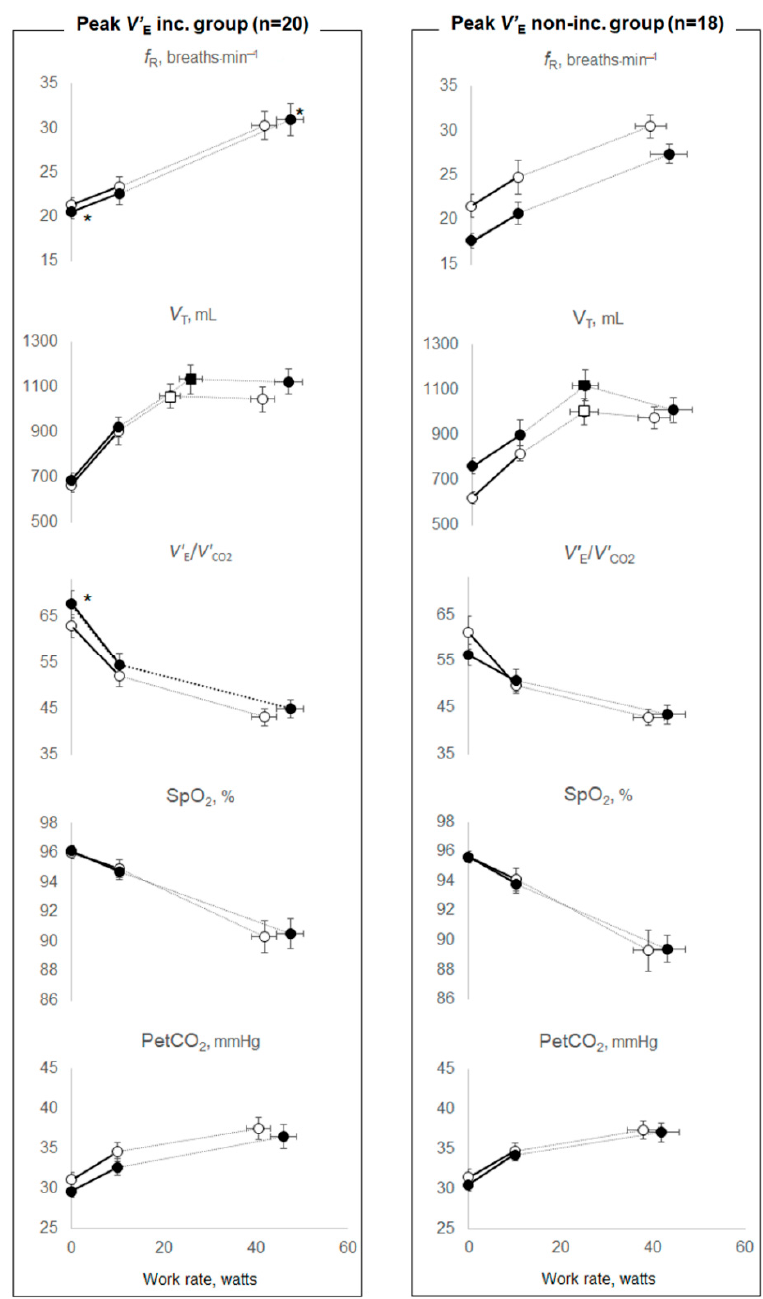
Figure 2. Exercise variables before and after pulmonary rehabilitation between the peak V’ E increase and non-increase groups. Data are presented as means (standard error). All patients were divided into two groups based on whether or not V’ E at peak exercise had increased after pulmonary rehabilitation. V’ E : minute ventilation; inc.: increase; f R : breathing frequency; V T : tidal volume; V’ CO2 : carbon dioxide output; SpO 2 : percutaneous oxygen saturation; PetCO 2 : partial pressure of end-tidal carbon dioxide. * p < 0.05: mean differences between pre-and post-pulmonary rehabilitation values at each exercise phase were compared between peak V’ E increase and non-increase groups. Open symbols: before pulmonary rehabilitation. Closed symbols: after pulmonary rehabilitation. Squares represent V T –ventilation inflection points.